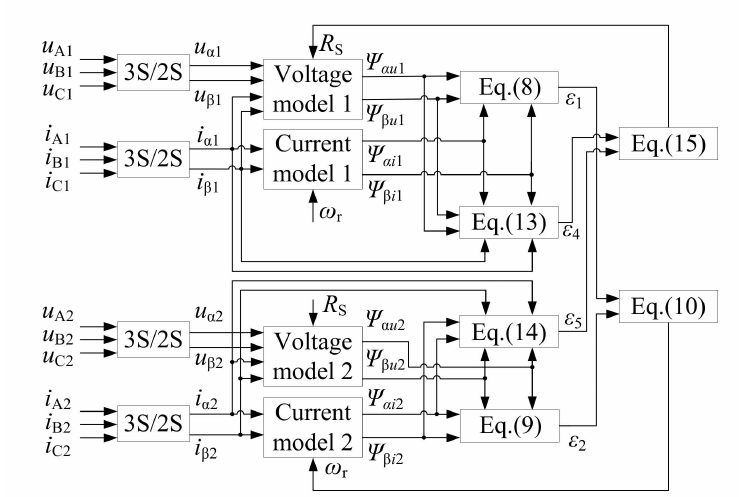
Figure 8. The block diagram of speed-estimation based on DCS with stator resistance identification.